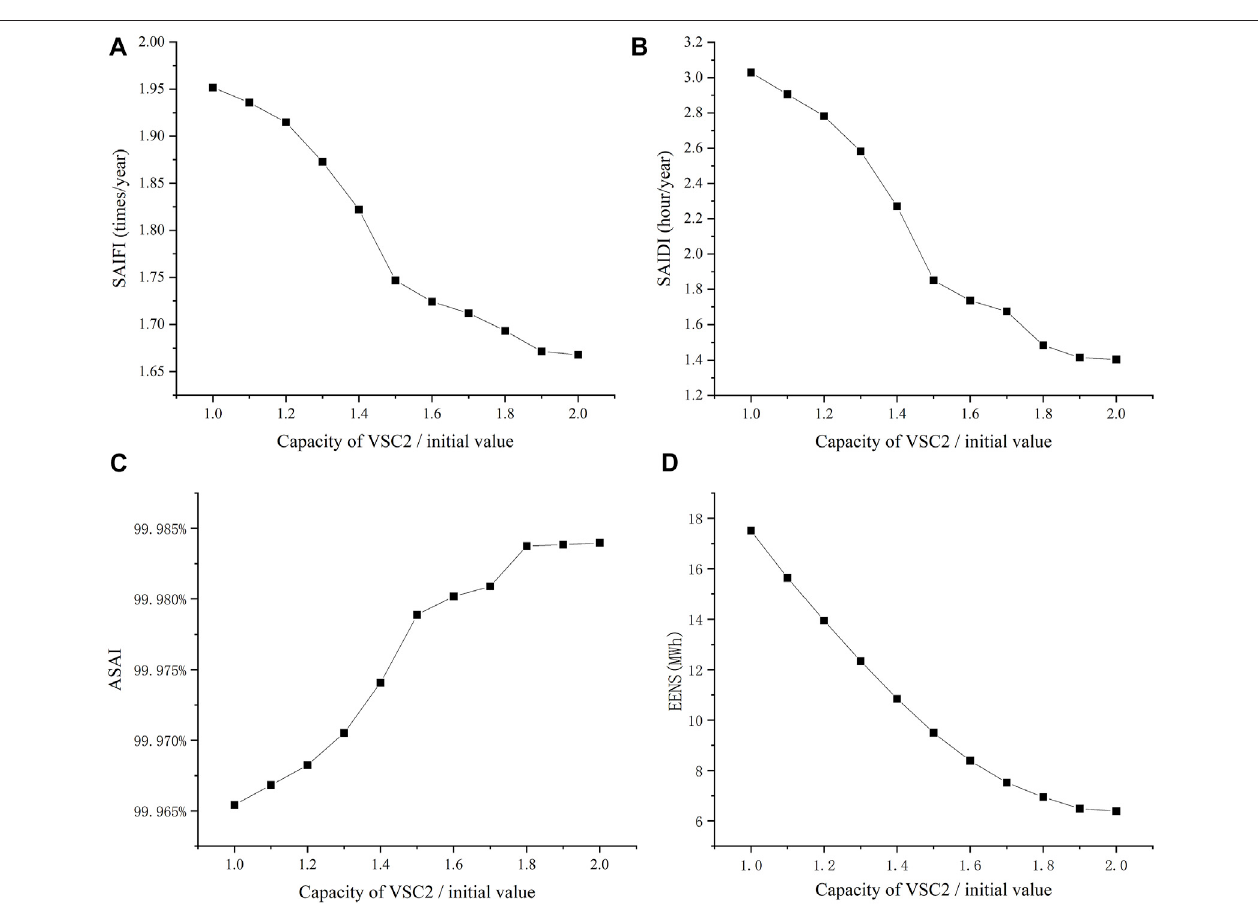
FIGURE 5 | Impact of the capacity of VSC 2 on system reliability indicators. (A) Impact of the capacity of VSC 2 on SAIFI. (B) Impact of the capacity of VSC 2 on SAIDI. (C) Impact of the capacity of VSC 2 on ASAI. (D) Impact of the capacity of VSC 2 on EENS.